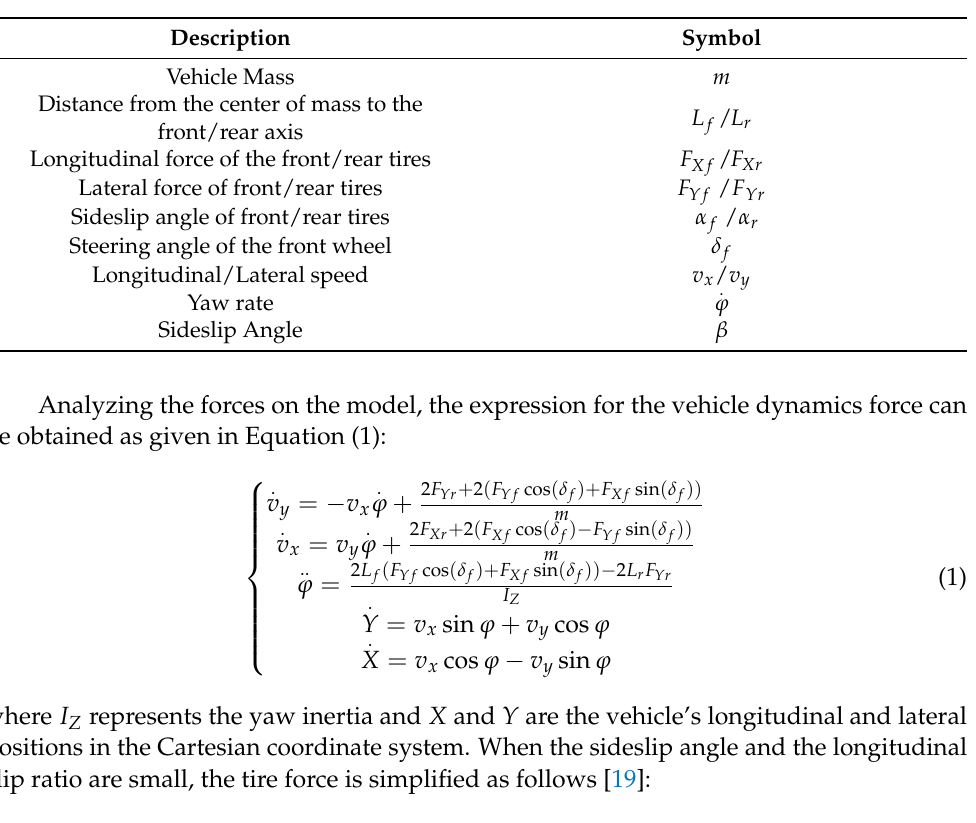
Figure 2. Vehicle dynamics model. Table 1. Vehicle Dynamics Parameters.